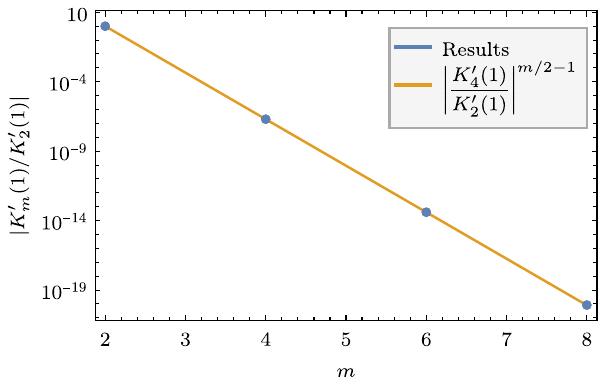
FIG. 11. Logarithmic plot showing the exponential decay of the nearest-neighbor m -point correlator K 0 m ð 1 Þ with m at K ¼ 0 . 1 . The blue data points represent the results obtained from the cumulant expansion of the RSMI-favored solution up to tenth order, while the yellow line shows the exponential decay with decay length obtained from the first two points. Only points for even m are present, as K m ð 1 Þ ¼ 0 for odd m due to reasons of symmetry. Again, at small K , the two-point correlator decays